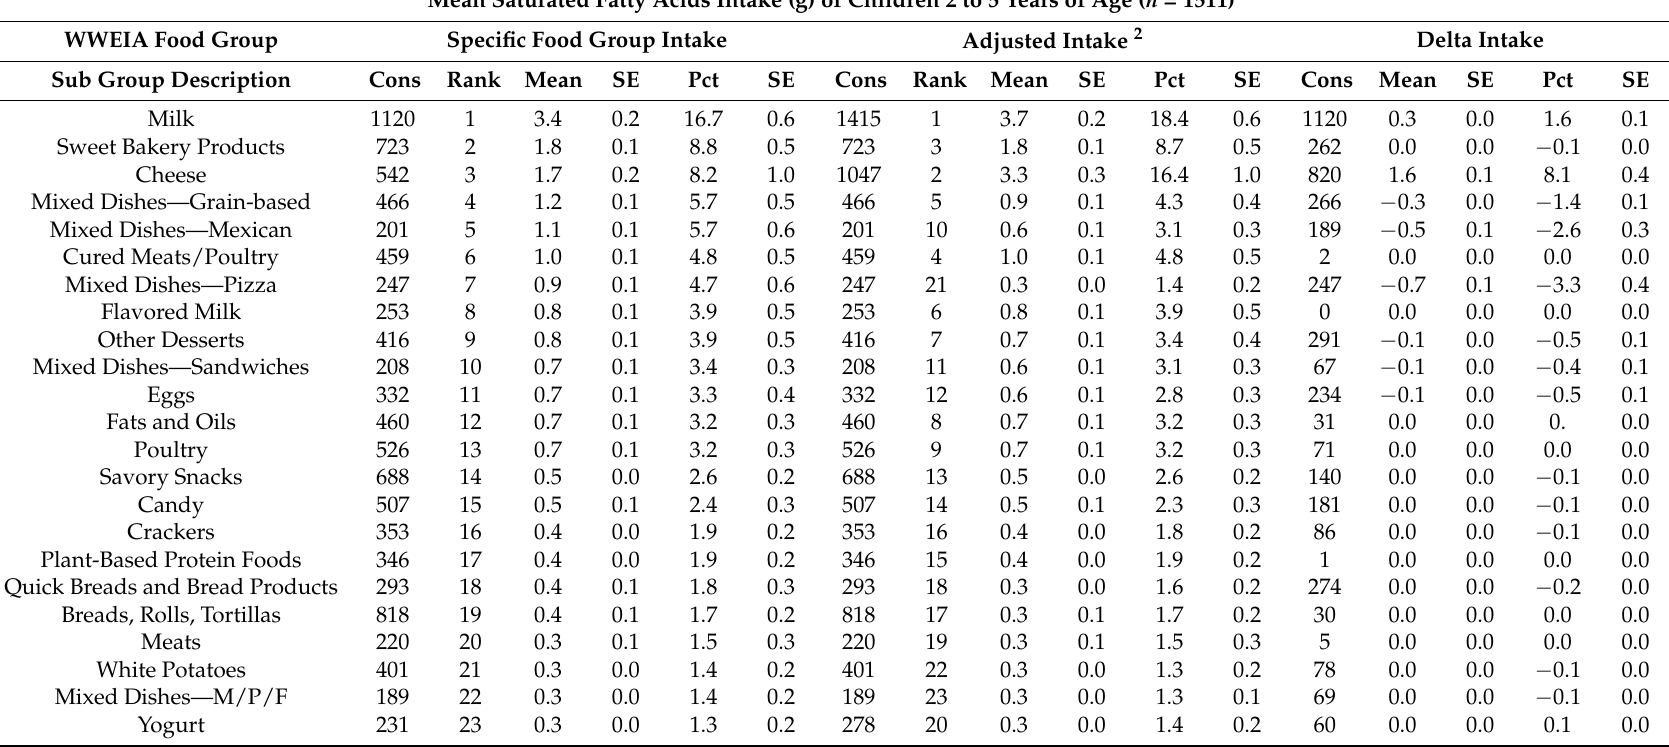
Table 7. Food/food group sources 1 of mean saturated fatty acids (g) intake among US children aged 2–18 years ( N = 5876): National Health and Nutrition Examination Survey